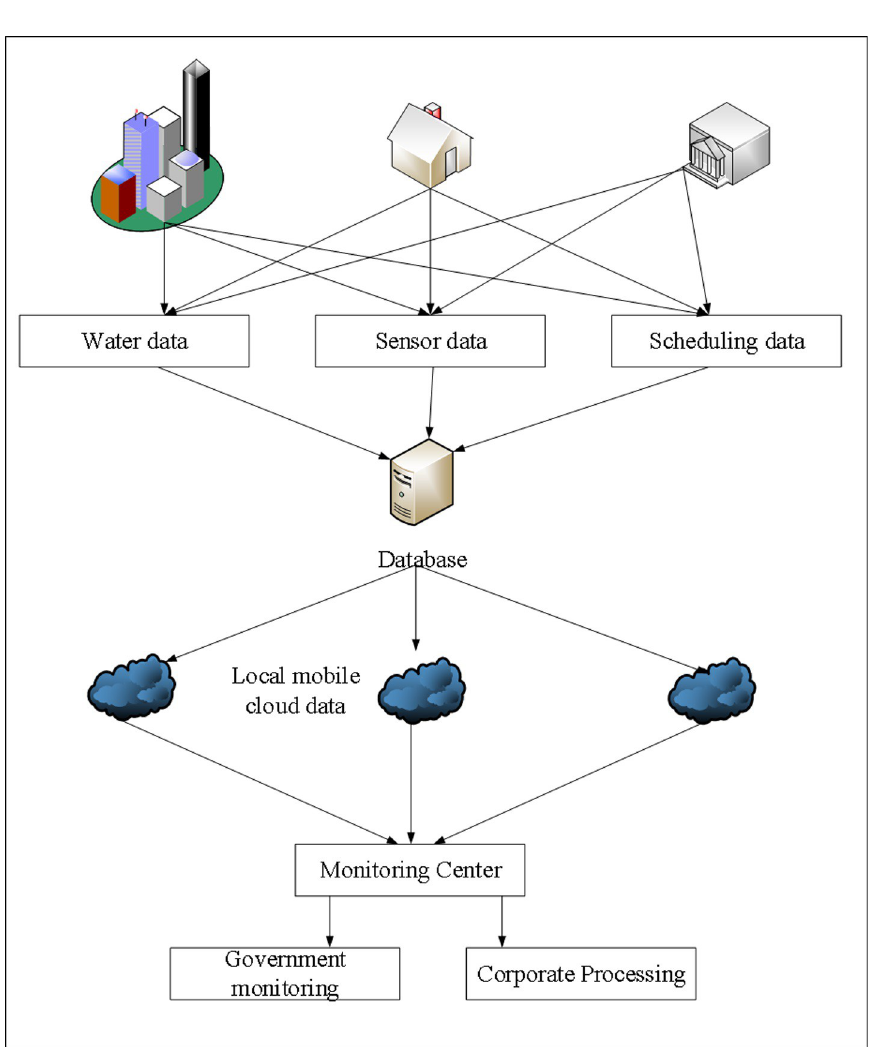
Fig 4. Flowchart of MEC